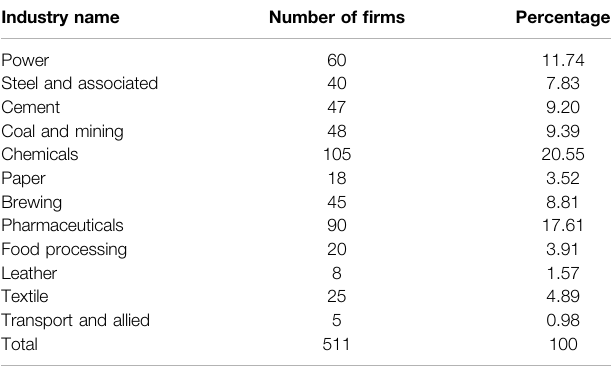
TABLE 1 | Sample distribution based on industries. Industry